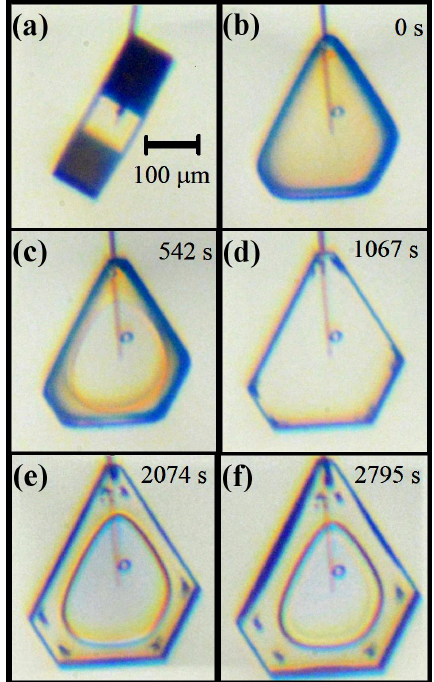
Figure 7. Corner-pocket and center hollow formation and changes on a non-symmetric crystal ( − 30 ◦ C, 0.8% supersaturation). (a) About 2h before sublimation. (b) Immediately after subli- mation, with growth period starting. (c) Basal facet spreading. (d) Clear corner pockets formed. (e) After normal growth, a cen- ter hollow on one basal and on top prism. (f) Further growth, some hollowing starting on wider prism